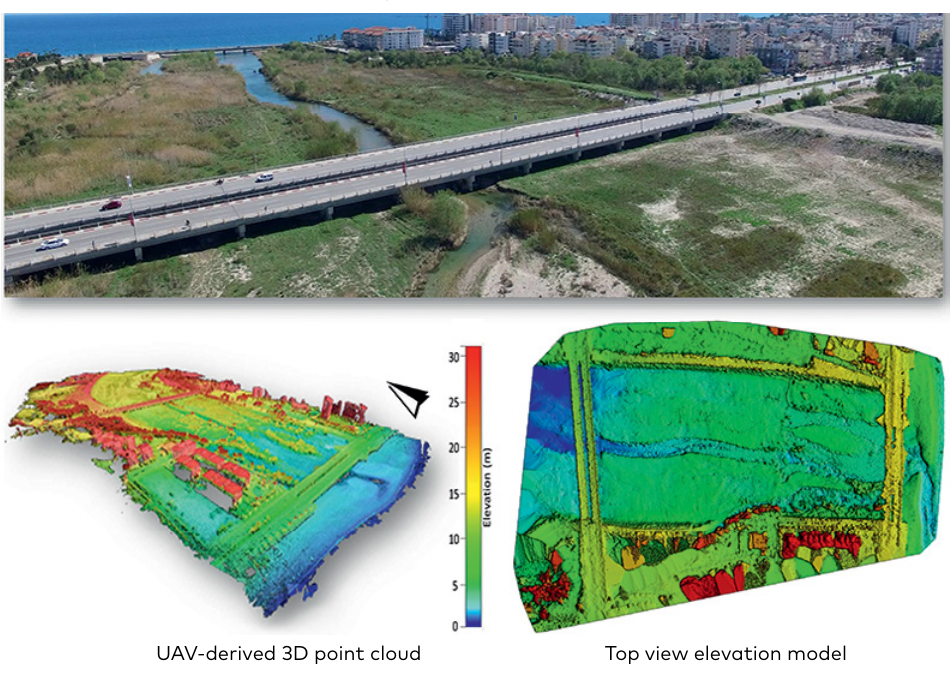
Figure 1. Case study region